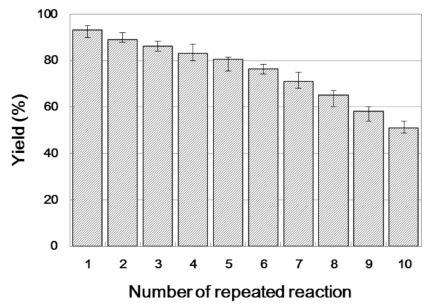
Figure 5. The influence of enzyme reusability on the enzymatic synthesis of β -amino alcohol 3a under continuous-flow